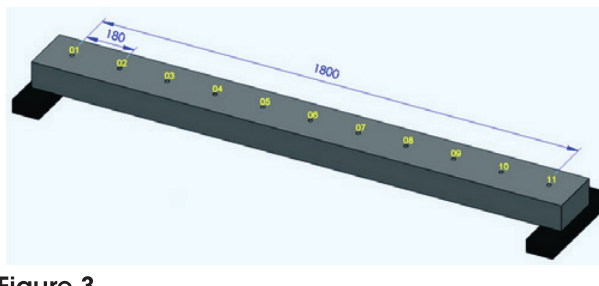
Bi-supported concrete beam, with installed data acquisition